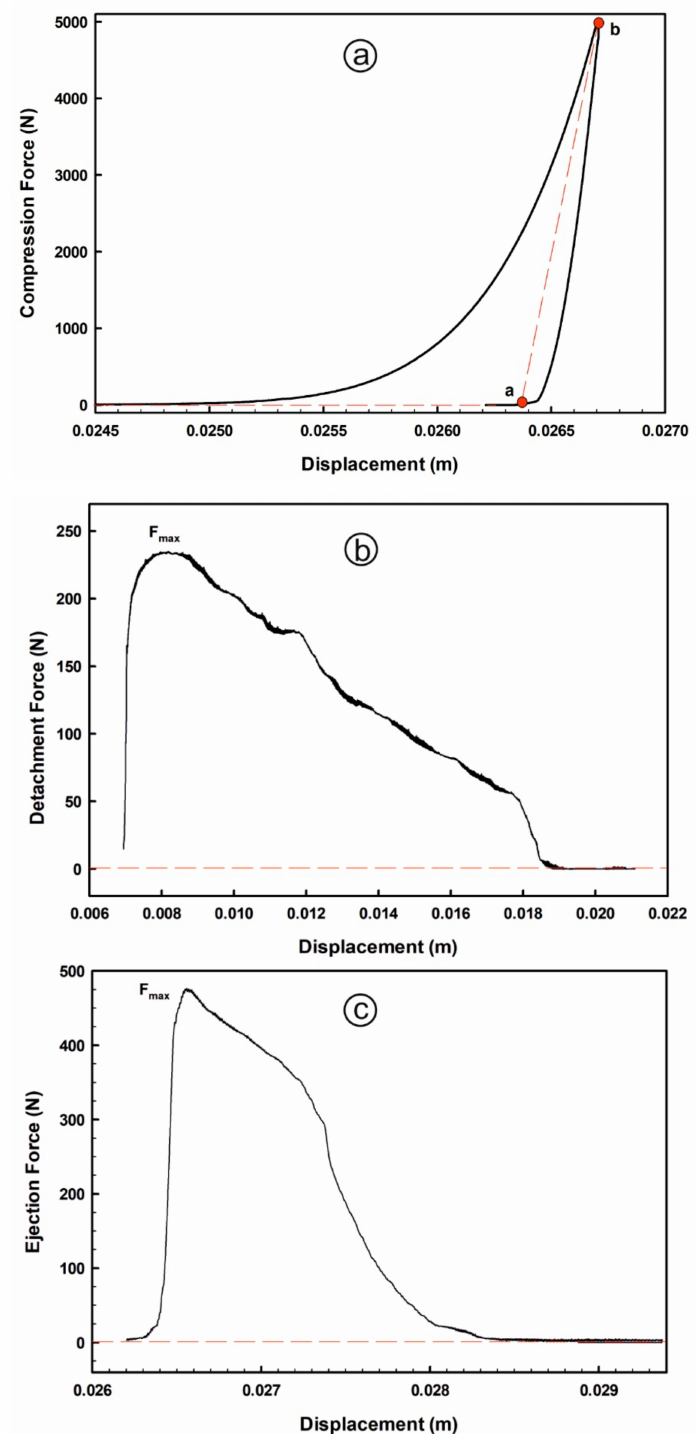
Figure 1. Representative average data of tableting profiles: ( a ) compression; ( b ) detachment and; ( c ) ejection